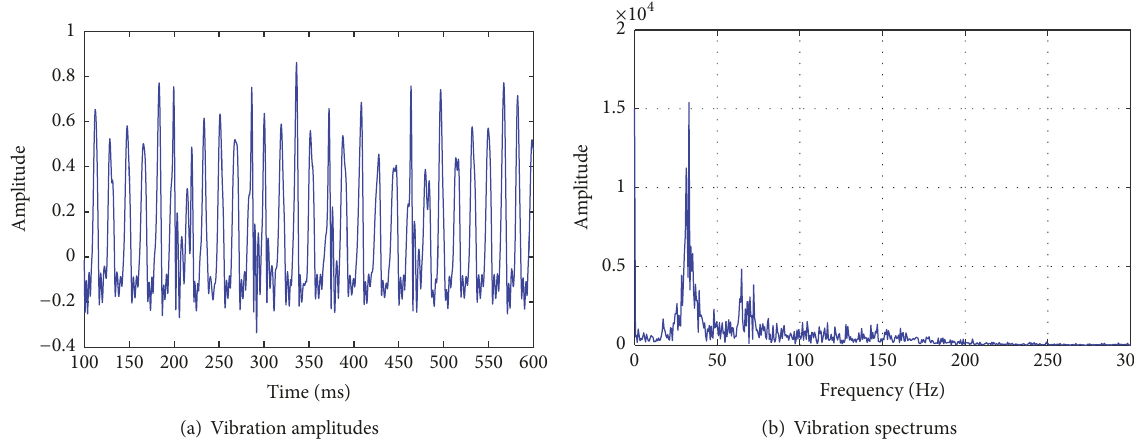
Figure 14: The horizontal direction response of the position of pedestal looseness ( 𝜆 = 0.5 , 𝛿 = 0.0001